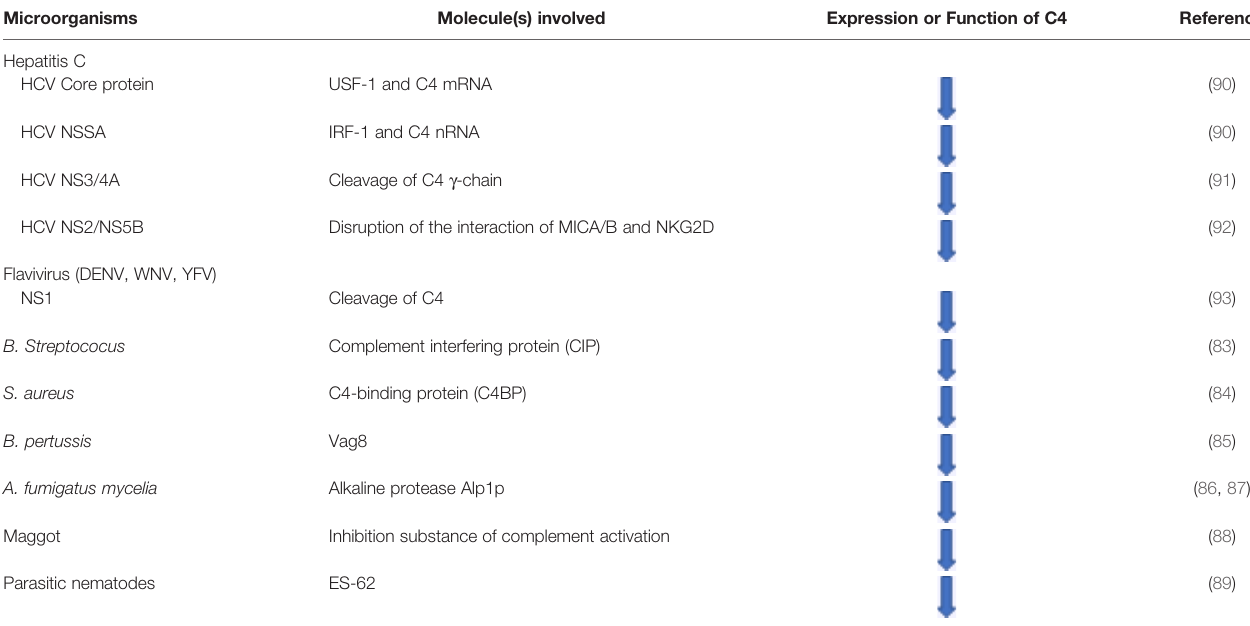
TABLE 1 | The evasion mechanisms of microorganisms from the attack of innate immunity of complement system by targeting complement C4. Microorganisms Molecule(s)